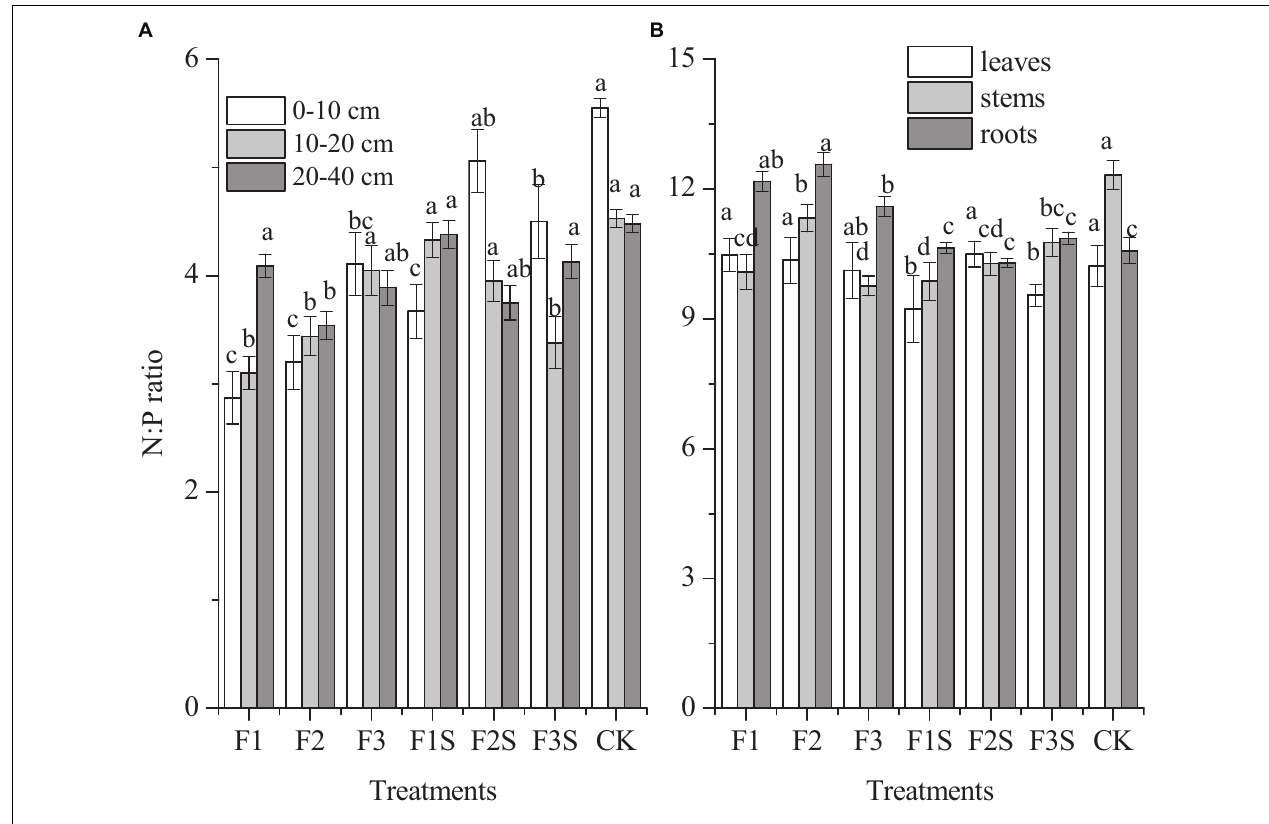
FIGURE 5 | The N:P ratio of soil (A) , leaves, stems, and roots (B) for different treatments. Different letters indicate significant differences among treatments (Tukey’s test, P ≤ 0.05).